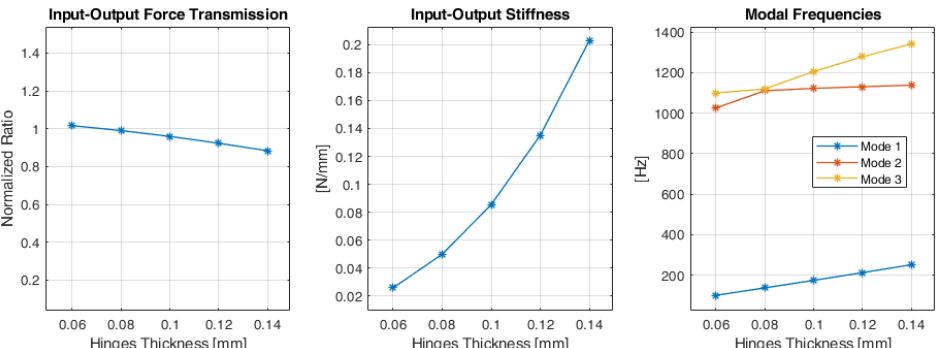
Figure 6. Results of the FEM modal analyses conducted by varying thickness of the flexure hinges. ( Left ): ratio between input (actuator side) and output (moving plate) linear force. ( Middle ): stiffness computed between input force and output displacement when moving in free air. ( Right ): modal frequencies of the first three modes of vibration